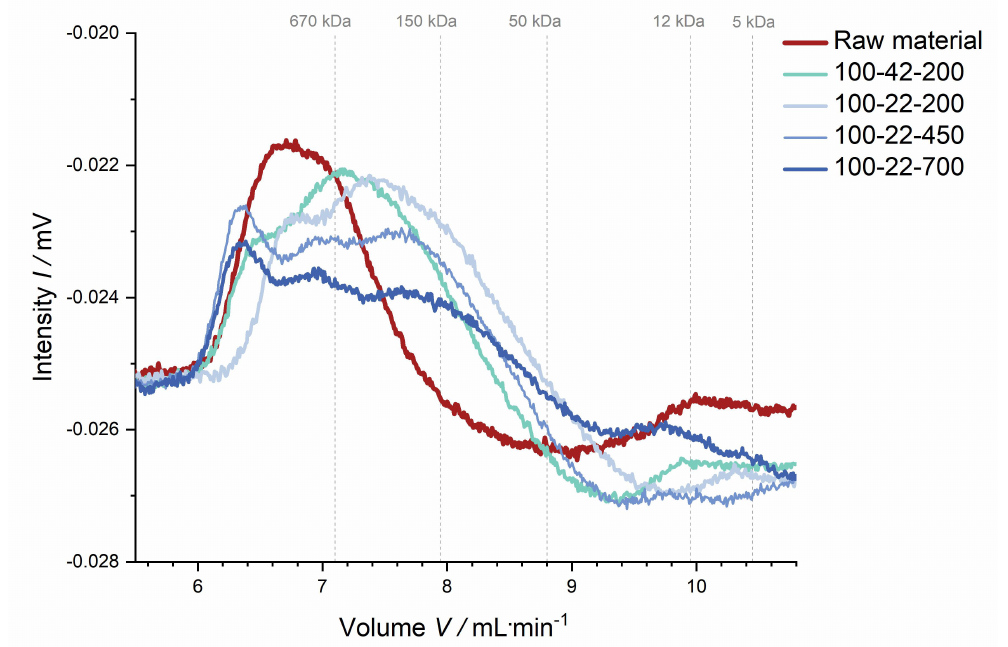
Figure 9. Molecular weight distribution of the soluble dietary fiber of raw and extruded apple pomace. The molecular weight distribution was determined by high-performance liquid chromatography with a refractive index detector. The intensity (refractive index detector signal) was plotted against the elution volume. Molecular weight calibration was performed by using dextrans (gray dotted lines). Table 2. Monosaccharide composition (mol%) of insoluble dietary fiber of raw and extruded